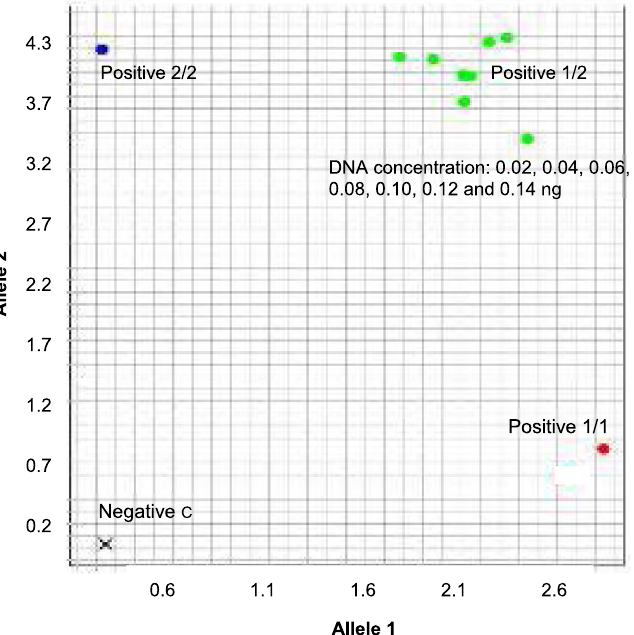
Figure 2. Detectability of DNA template with TaqMan assays. For DNA extracted from dried blood samples, the amplified SNP locus was rs1528460, and the positive DNA control used 0.06 ng of the DNA template for real-time PCR amplification.